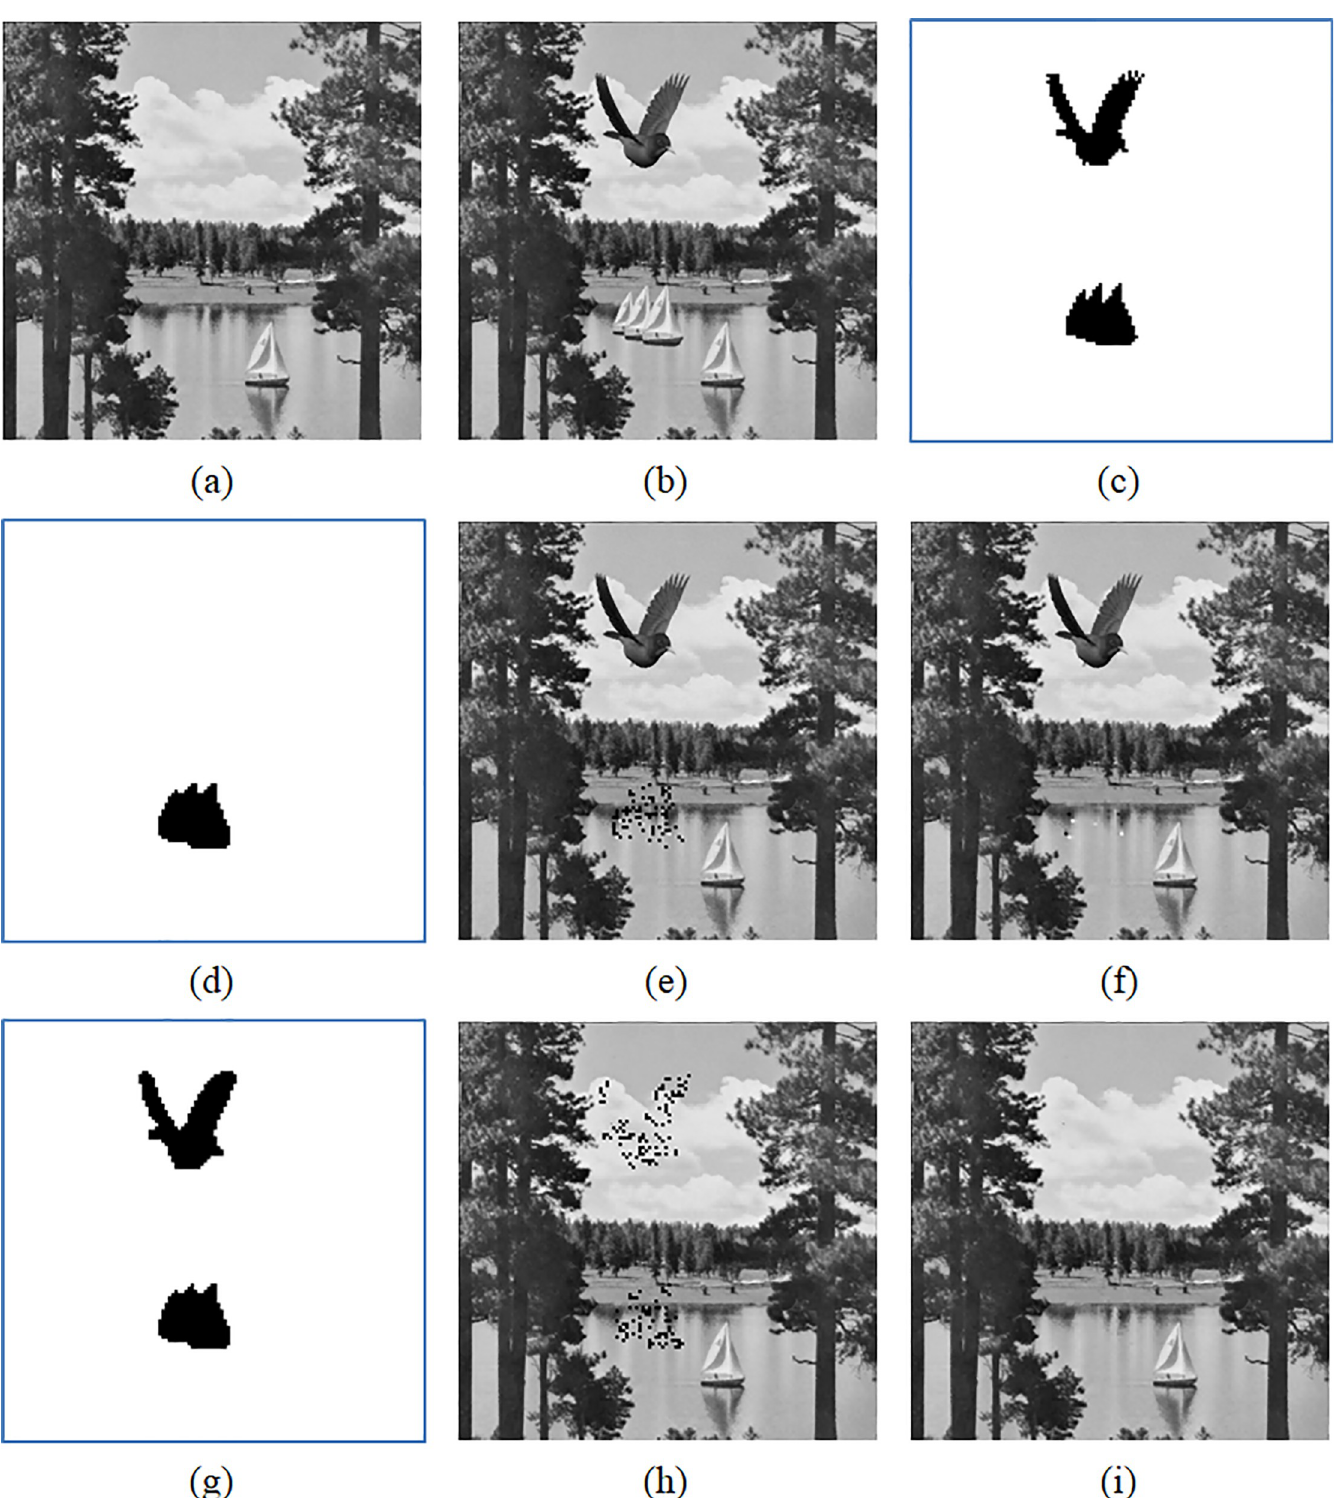
Fig 8. Comparisons of the detection and recovery results for a special tampering. (a) Marked image. (b) Tampered image. (c) Tampered regions. (d) Second-stage detection of Hu et al.’s method. (e) First-stage recovery of Hu et al.’s method. (f) Second-stage recovery of Hu et al.’s method. (g) Second-stage detection of the proposed method. (h) First-stage recovery of the proposed method. (i) Second-stage recovery of the proposed method.